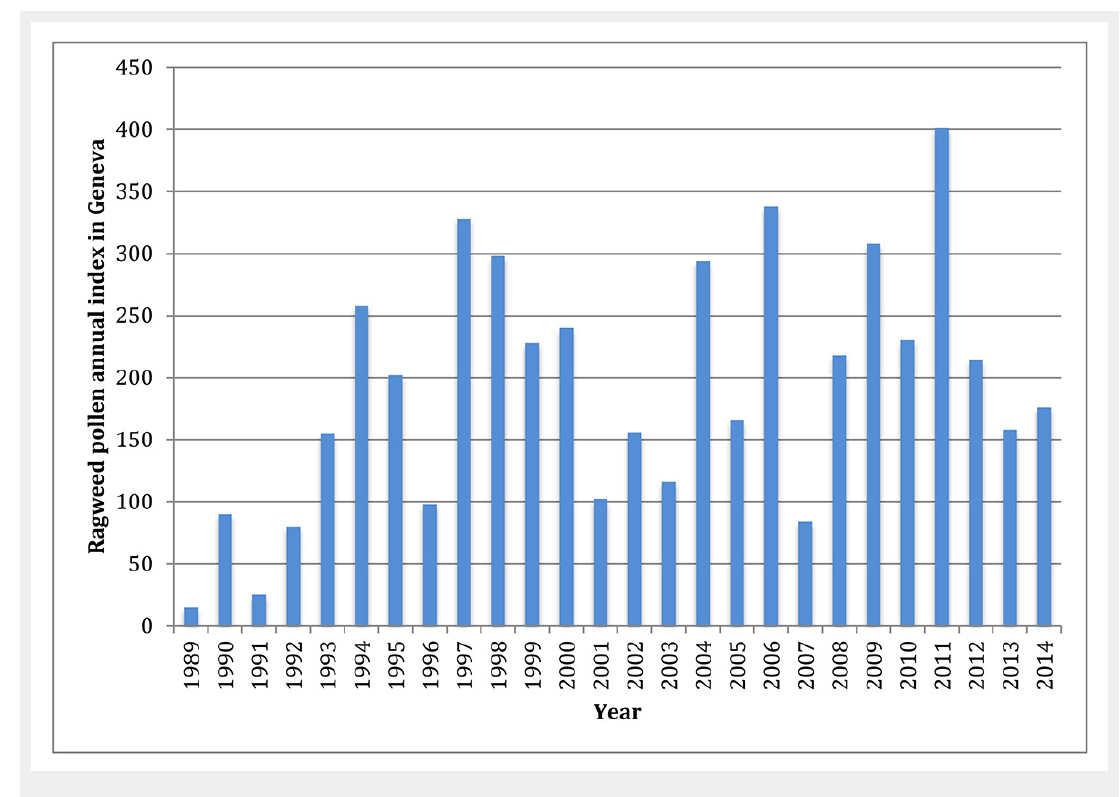
Figure 3 Ragweed annual pollen counts over 20 years in Geneva (source: